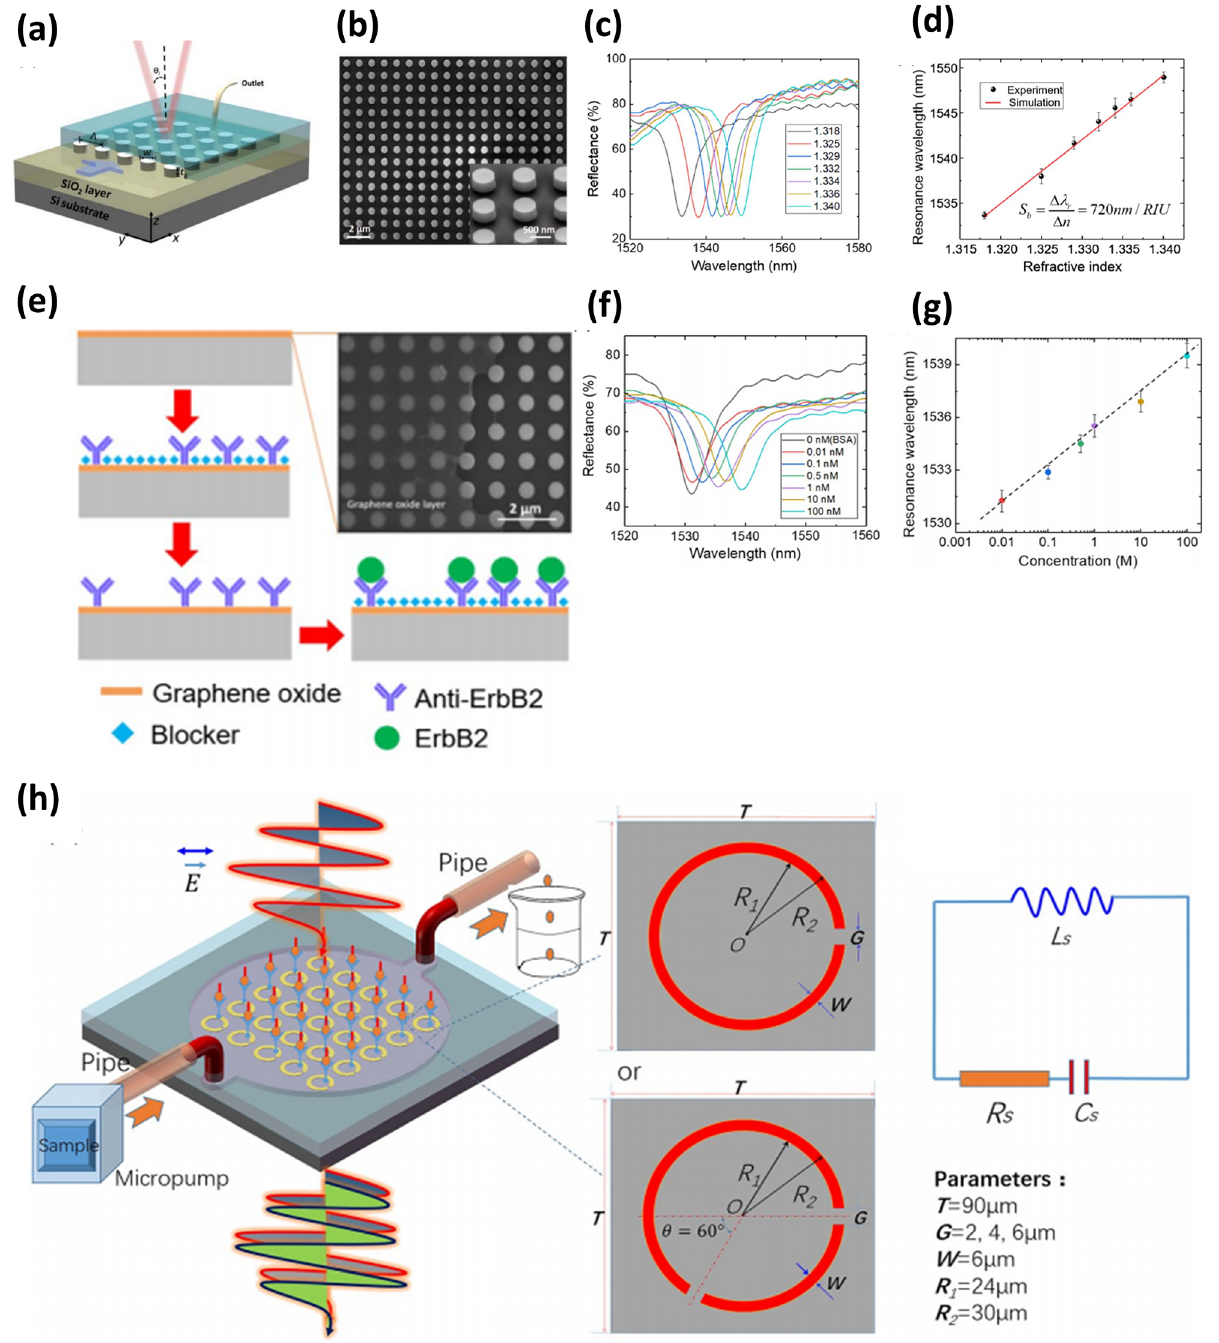
Figure 8: Cancer biomarkers detection. (a)Schematicofthemetasurfacewithasiliconnanopostarray.ThesensorsurfacewasintegratedwithaPDMSbasedoptofluidicchamberforcancer biomarkerdetection.(b)SEMimageofthenanopostarray.(c)Measurementresultsforethanolsolutionswithdifferentrefractiveindexvalues(1.318 – 1.340 RIU). (d) Experimental and simulated sensor response curve of the metasurface sensor. (e) The sensor surface was functionalized with anti- ErbB2 molecules for the detection of early-stage breast cancer protein biomarker, epidermal growth factor receptor 2 (ErbB2), by monitoring the plasmonicresonancewavelengthshift. (f) There fl ectionspectrafor different concentrations of ErbB2protein(0.01 – 100 nM).(g) Thedose – response curvefortheErbB2protein.Thedetectionlimitwasfoundtobe0.7ng/ml.(a) – (g)ReproducedwithpermissionfromWangetal.,Biosens.Bioelectron. 107 , 224 – 229 (2018) [146]. Copyright 2018 Elsevier. (h) (Left) Schematic of the THz metasurface integrated with a micro fl uidic chip. (Right) Design of the meta-atom. (i) Transmission spectra of alpha-fetoprotein (AFP) with the single split-ring resonator. The black curve represents the metasurface without samples and the red curve represents the metasurface with biomolecules. (j) Transmission of GGT-II with the single split-ring resonator. (k) Transmission of AFP with the double split-ring resonator. (l) Transmission of GGT-II with the double split-ring resonator. (h) – (l) Reproduced with permission from Geng et al., Sci. Rep. 7 , 16378 (2017) [147]. Licensed under a Creative Commons Attribution 4.0 International